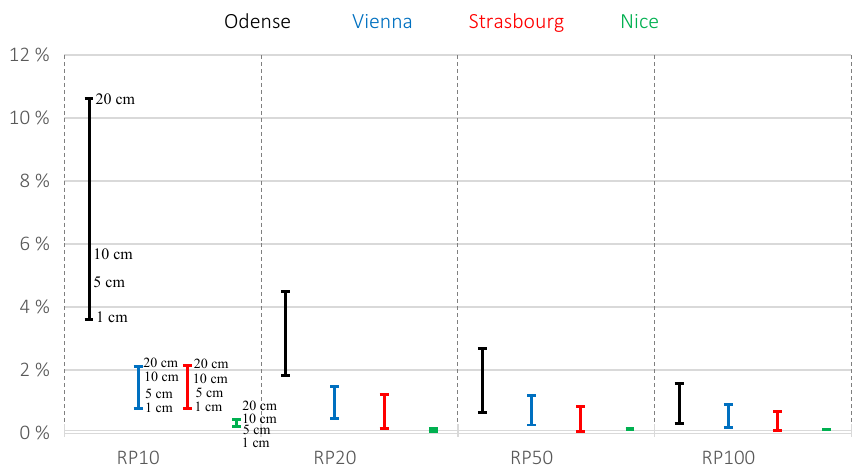
Figure 9. Relative change in flooded area per 1% increase in imperviousness. Results are shown as the range of change for water depths of 1, 5, 10 and